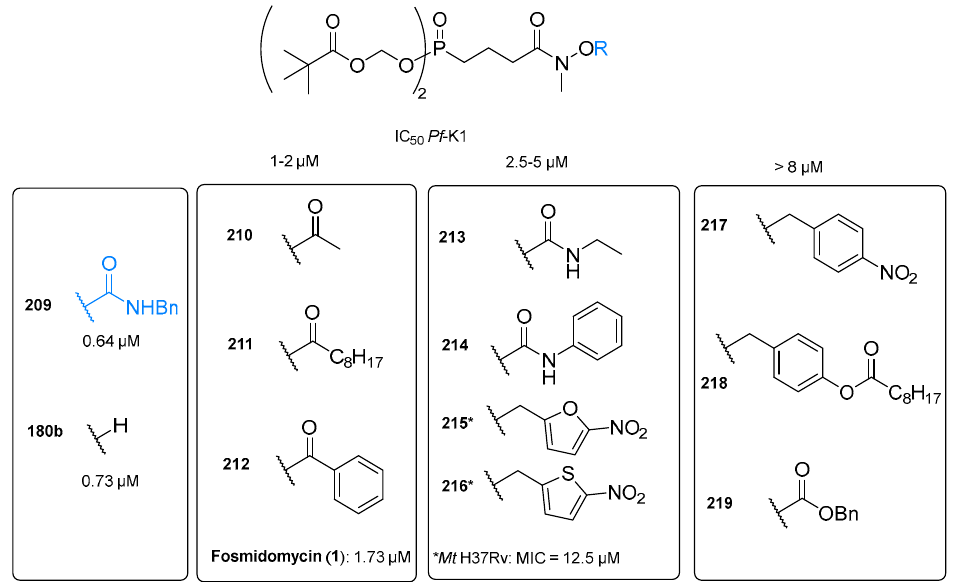
Figure 40. Antiplasmodial activity of double prodrugs 209 – 219 against asexual blood stages of Pf -K1 (IC 50 in µM) and Mt H37Rv (MIC in µM).